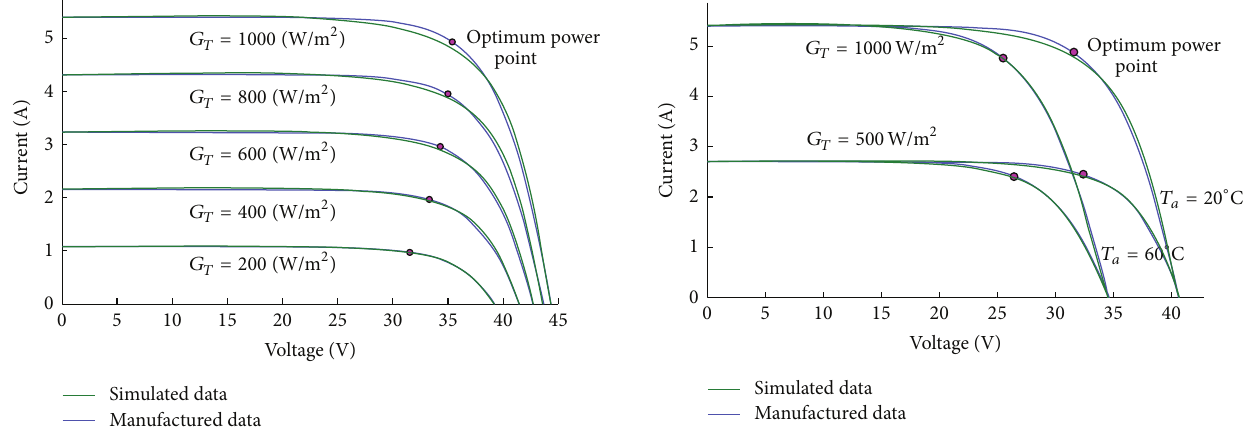
Figure 4: I-V characteristic curves at various solar radiation levels.